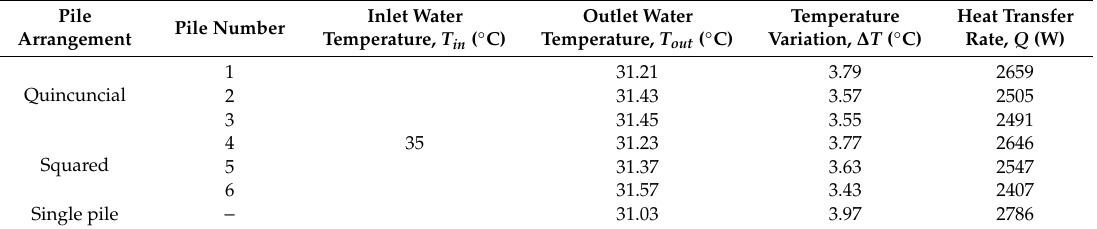
Figure 10. Outlet water temperature variation of Piles #4, #5, and #6 in the squared arrangement and the single pile. Table 7. Comparison of thermal performance between Piles #1, #2, and #3 in the quincuncial arrangement versus Piles #4, #5, and #6 in the squared arrangement and single pile.